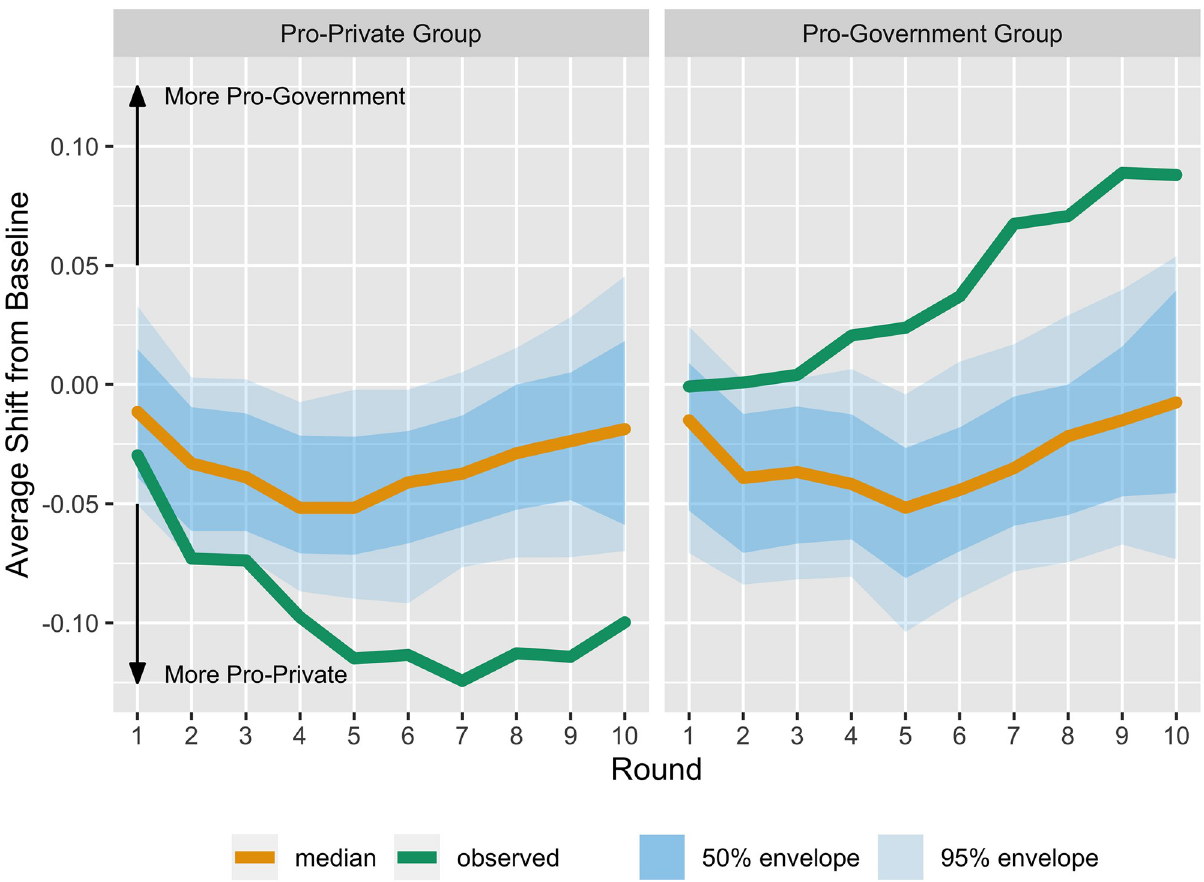
Fig 4. Marginal score shift from baseline by assigned official information treatment group. The green line in the left panel displays the progression across the 10 rounds of the average score shift from baseline (time 0), for those assigned to view proprivate funding messages, disregarding the possible indirect effect of messages shown to friends. Negative score shifts indicate that on average participants in this group express opinions that are more proprivate than they had at baseline. The orange lines are median (most usual) progressions and blue bands are 50 and 95 percentile envelopes constructed via the permutation reference distributions for these same progressions. The right panel displays the same attributes for the group randomly assigned to view progovernment messages.